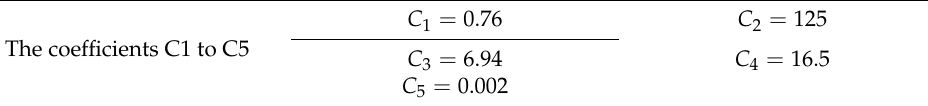
Table A1. Performance factor coefficients [26].